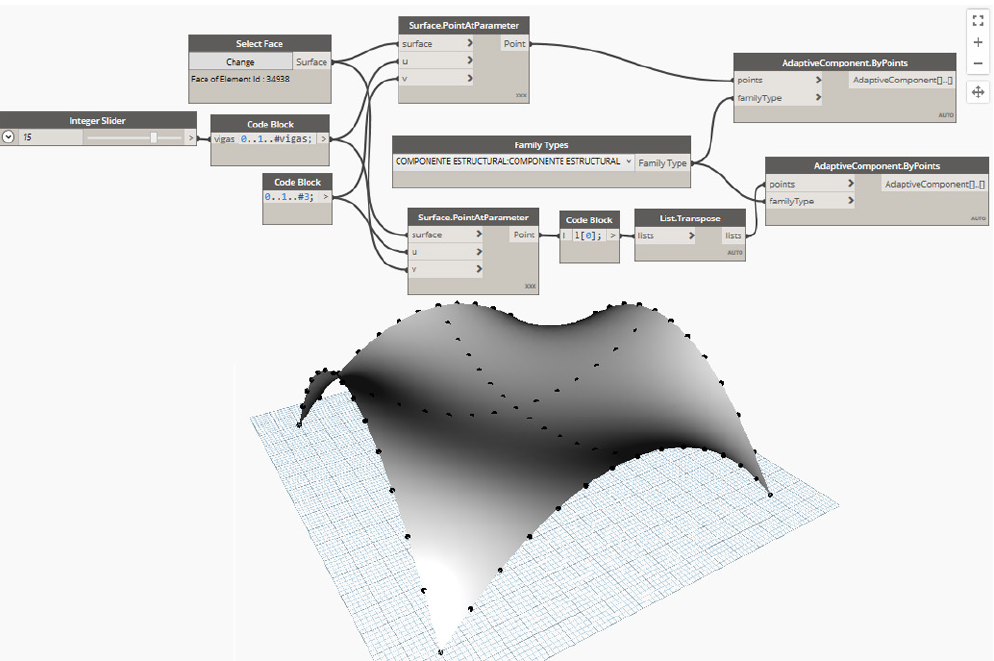
Fig. 7 Visual Design.